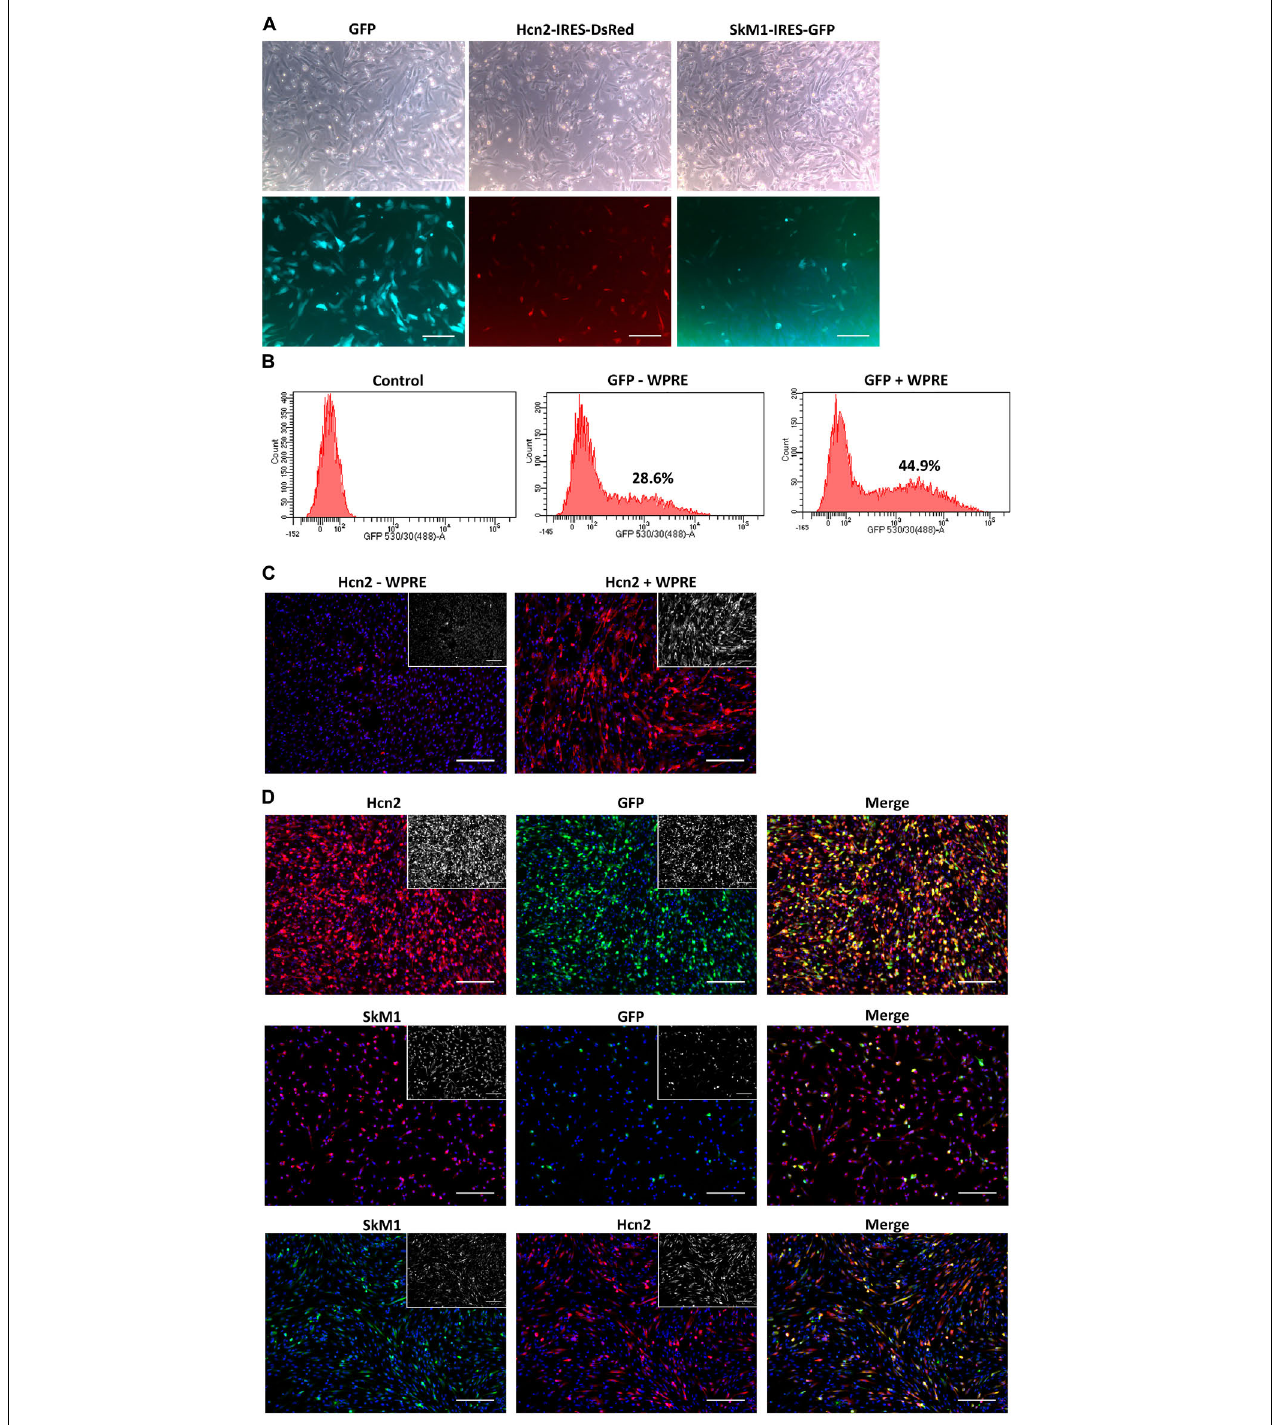
FIGURE 2 | Nucleofection optimization of CPCs. (A) Nucleofection with GFP (left panels), Hcn2 (middle panels) or SkM1 (right panels) plasmids with IRES driven reporter markers. Upper panels show bright field images of nucleofected CPCs and lower panels show expression of reporter markers (DsRed in red and GFP in green). Scale bars represent 200 µ M. (B) FACS data of GFP expression in nucleofected CPCs with a GFP plasmid with (right panel) or without (middle panel) the WPRE motif. Control cells (left panel) do not express GFP. Percentages indicate the % GFP-positive counted cells. (C) Immunocytochemistry of nucleofected CPCs with an Hcn2 plasmid, without or with WPRE motif (left and right panel, respectively). Hcn2 is stained in red and nuclei are counterstained in blue. Staining without DAPI is shown in the insets. (D) Immunocytochemistry of co-expression of Hcn2 (upper panels) and SkM1 (middle panels) with GFP nucleofected CPCs in 4:1 ratio. Lower panels show co-expression of Hcn2 and SkM1 in 1:1 ratio. Staining without DAPI is shown in the insets. Scale bars represent 200 µ M, n = 2.